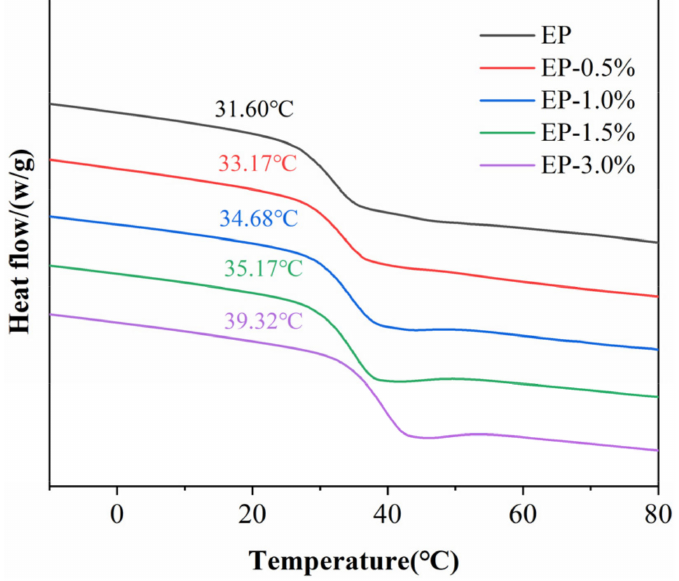
Figure 7. The differential scanning calorimeter (DSC) curves of MWCNTs@PDA epoxy composites (exo